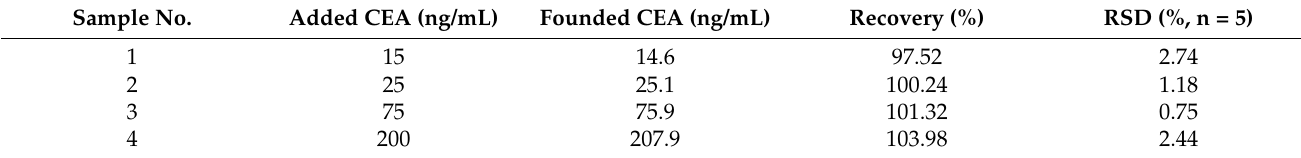
Table 2. Analytical results for the determination of CEA in clinic serum samples.